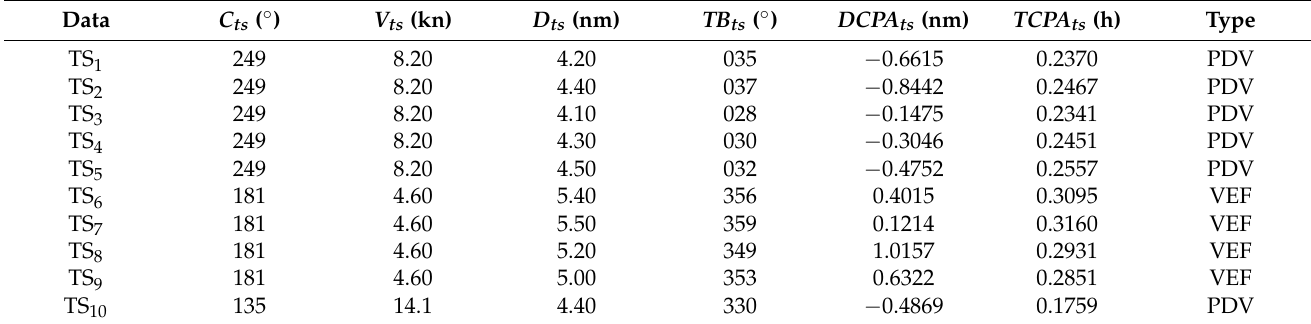
Table 7. Data of target ships at 0000.